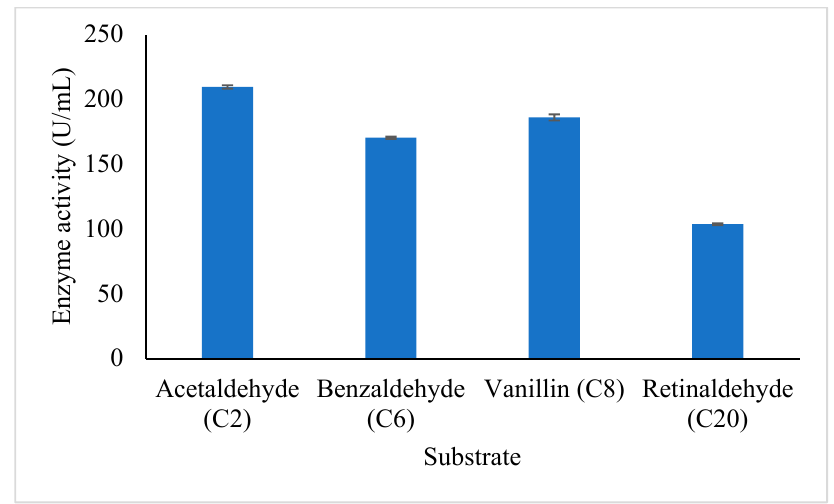
Figure 7. Effect of aliphatic and aromatic substrate on the purified A. geothermalis ALDH. The A. geothermalis ALDH was assayed at 60 ° C for 10 min.